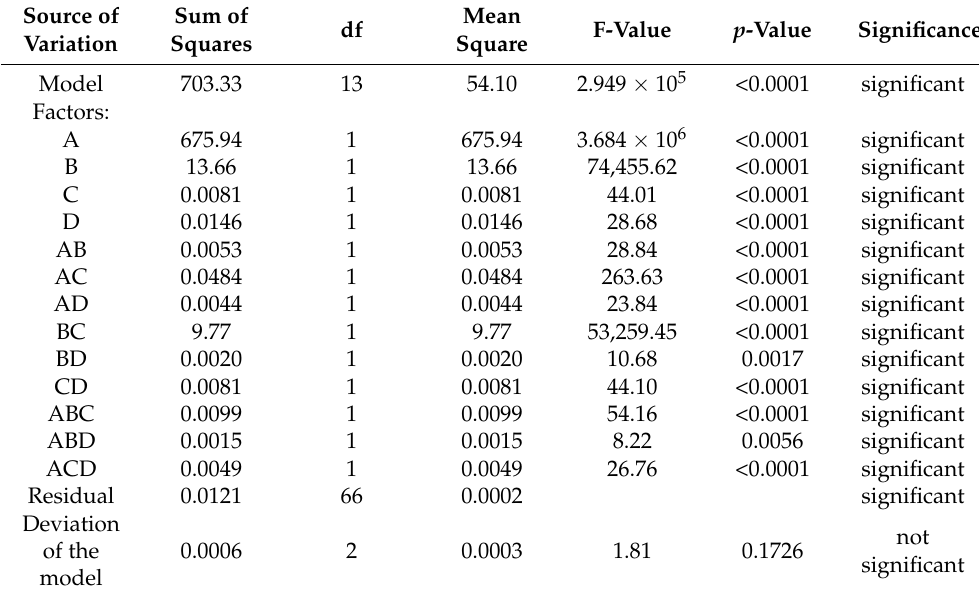
Table 5. ANOVA-Hybrid